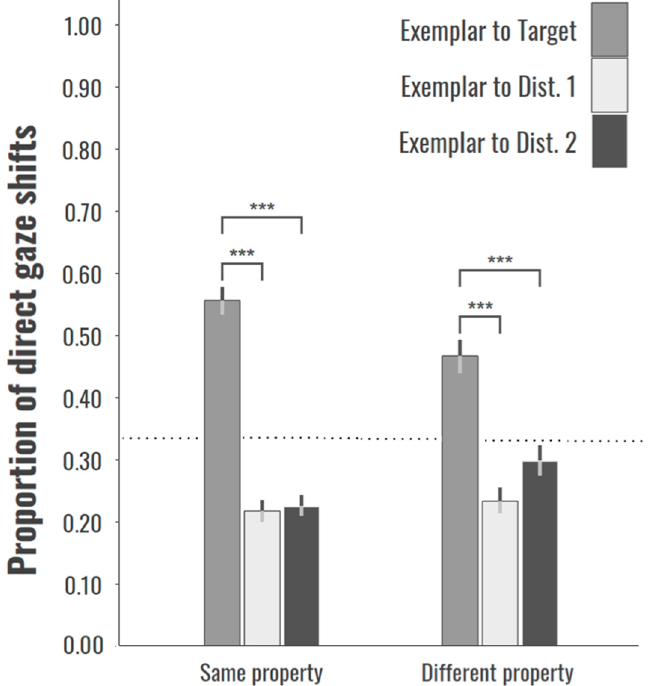
Figure 5. Mean proportion of frequencies of direct gaze shifts to the target or distractor objects from the exemplar object. Bootstrapped standard errors are shown as vertical lines, and the horizontal dotted line is chance performance at 0.33.